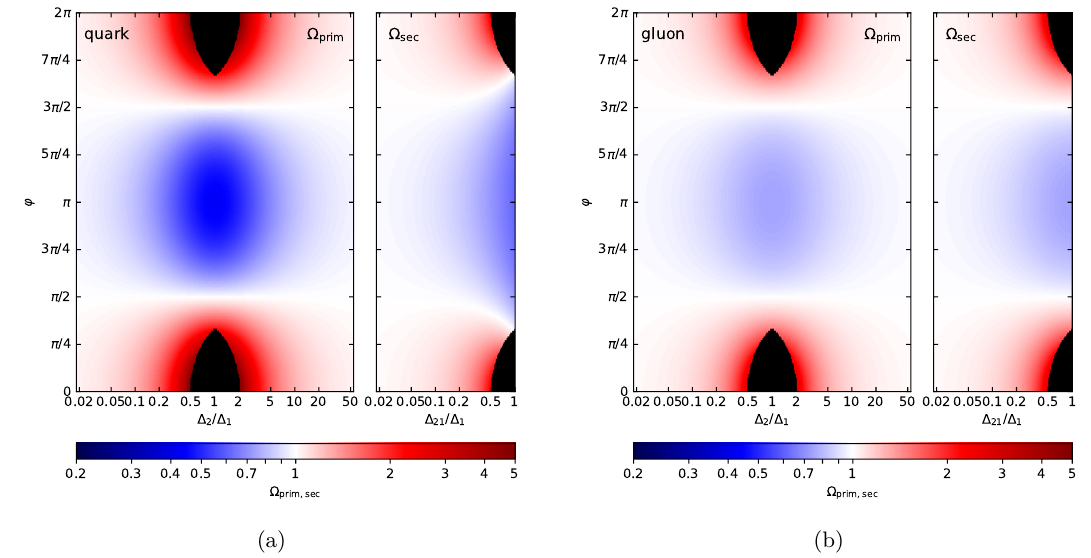
Figure 2. Clustering correction factors Ω prim (primary) and Ω sec (secondary) for quark (left) and gluon (right) leading partons. The black regions correspond to the kinematic regions where emissions are not clustered in the indicated Lund